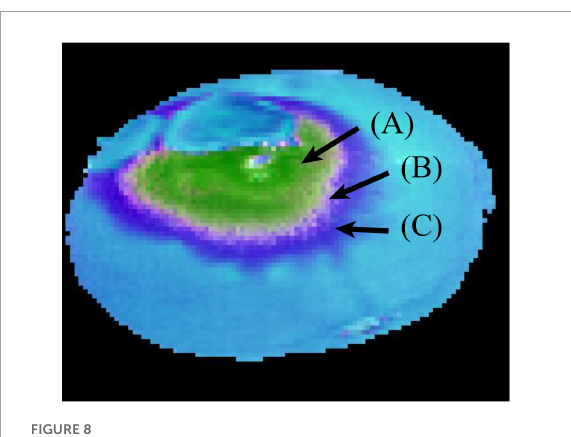
5,200 modeling data points. These data were randomly divided into a training dataset, validation dataset, and test dataset